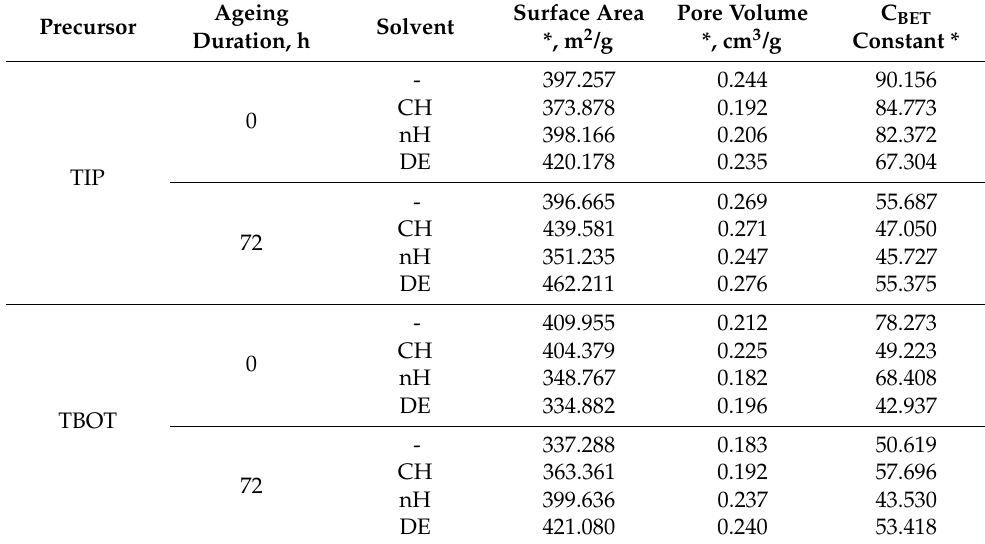
Table 1. The morphology of the TiO 2 aerogels versus precursor, solvent type, and ageing duration.